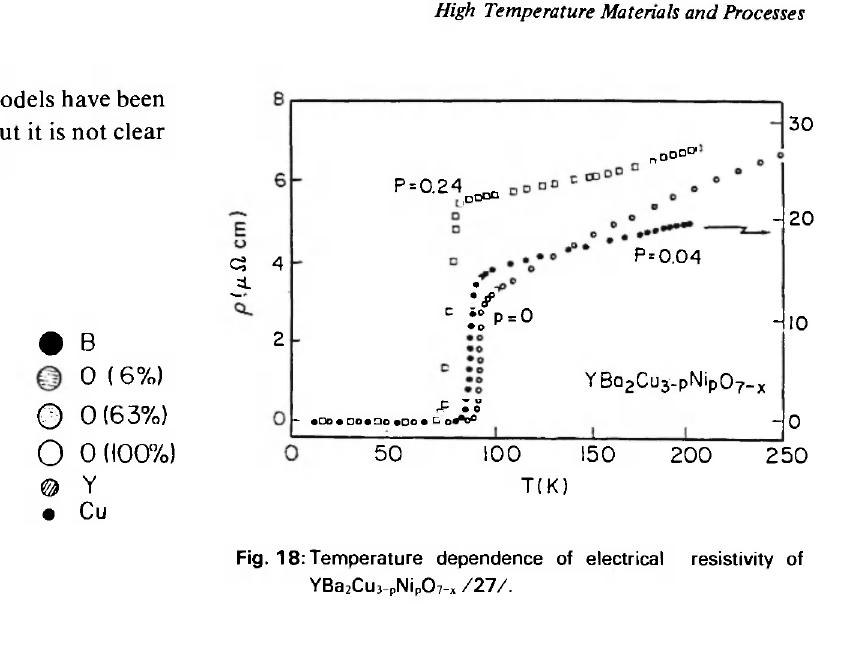
Fig. 18: Temperature dependence of electrical resistivity of YBa 2 Cu 3 -pNi p 07 -x